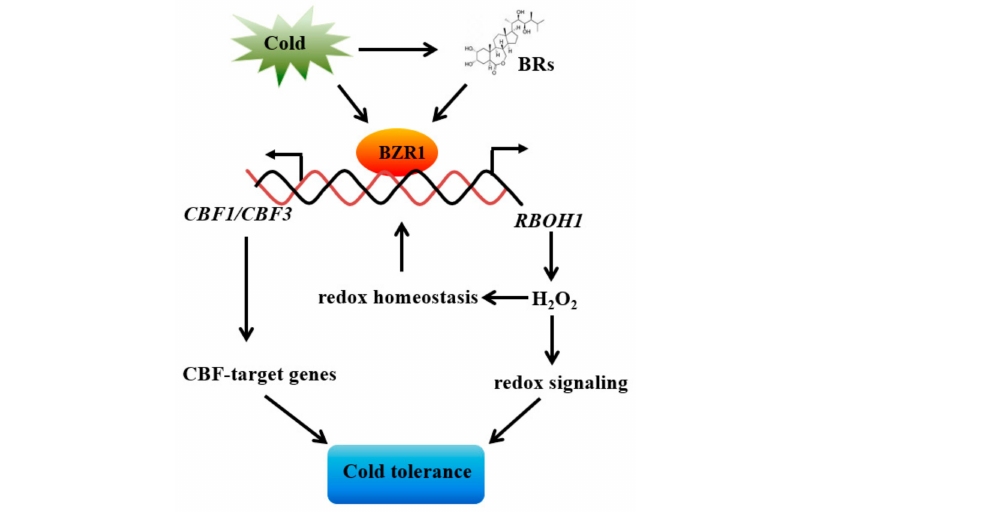
for different periods of time, Figure S4: BZR1 is essential for BR-induced cold tolerance. Figure S5: Yeast-one hybrid analysis of BZR1 binding to the promoters of CBF1 and CBF3 in tomato, Figure S6: Silencing efficiency of RBOH1 in BZR1 :OE plants, Figure S7: Role of RBOH1 in BR-induced cold tolerance, Figure S8: The GSH and GSSG contents in WT and RBOH1 -RNAi plants under cold condition, Figure S9: RBOH1 plays a role in BR-induced cold tolerance by redox regulation, Figure S10: H 2 O 2 and GSH treatment rescue the cold tolerance of RBOH1 -silenced plants, Table S1: Primers used for VIGS constructs, Table S2: Primers used for qRT-PCR analysis, Table S3: Multiple reaction monitoring conditions used for LC-MS/MS analysis Table S4: Primers used for pAbAi-baits and AD-prey constructs, Table S5: Primers used for ChIP-qPCR analysis, Table S6: BR contents in tomato leaves under control and cold